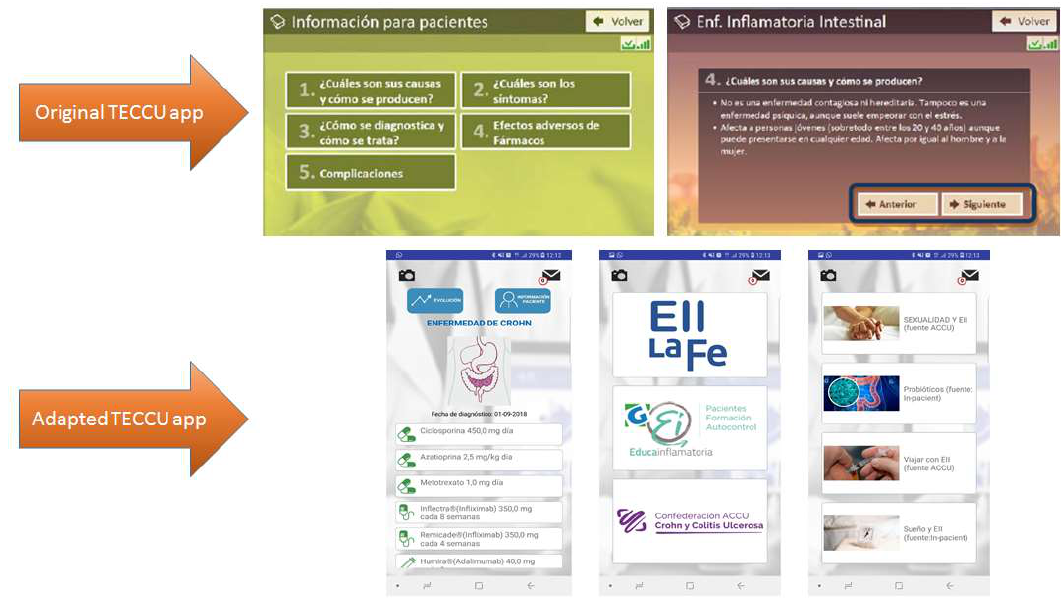
Figure 5. Updates to the educational contents and the summary of the patients’ disease course in the TECCU app.